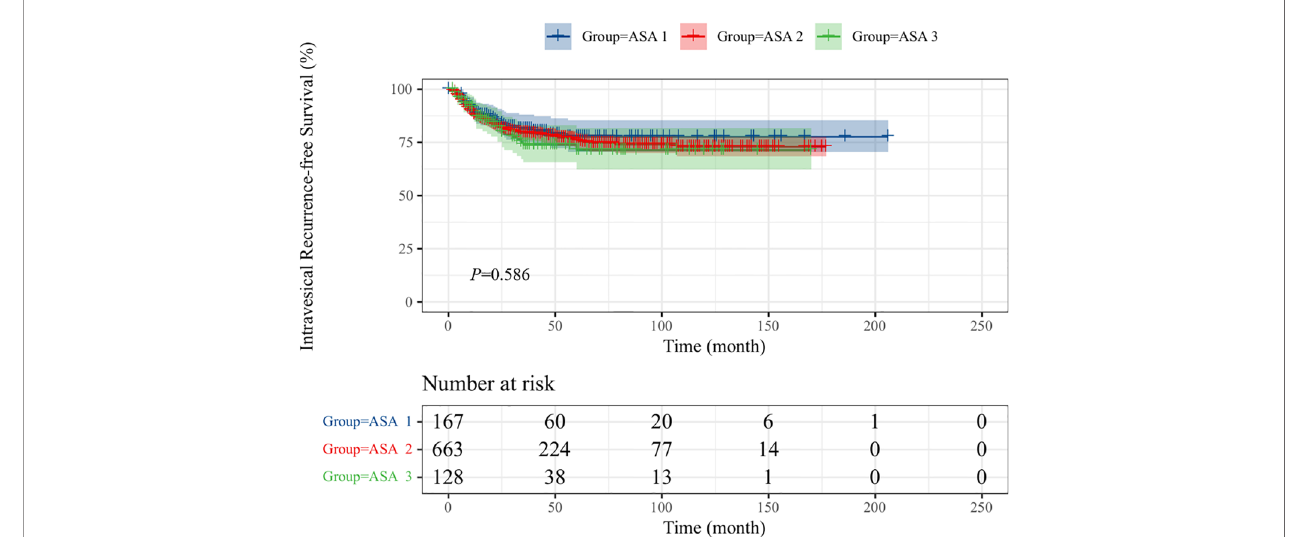
FIGURE 4 | Kaplan-Meier curves for IRFS strati fi ed according to ASA scores.